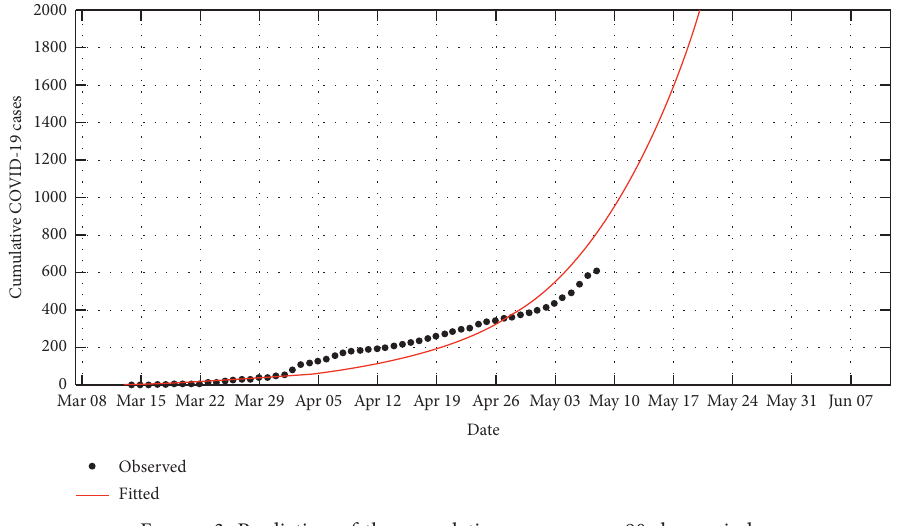
Figure 3: Prediction of the cumulative cases over a 90-day